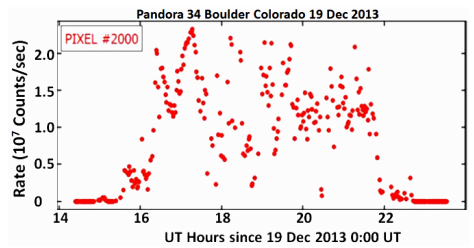
Figure 7. Scatterplot comparisons (a) between Pandora TCO mea- surements and those from OMI and (b) comparison with those from NPP. Shown are the correlation coefficient r 2 , slope, and y inter- cept.